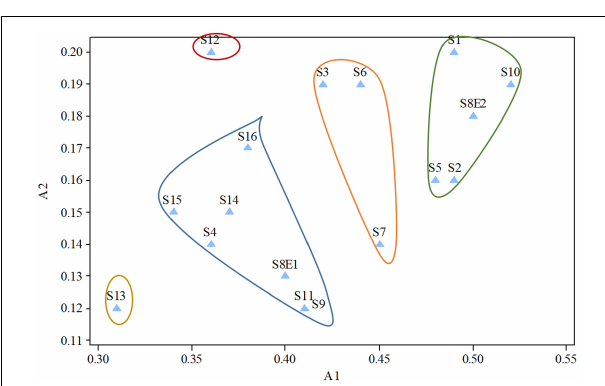
FIGURE 9 | Two-dimensional graphic of the Romero-Zarco asymmetry indices (A1: intrachromosomal asymmetry index, A2: interchromosomal asymmetry index) of 16 species (17 population) Pimpinella species. S1 ( P. affinis ), S2 ( P. eriocarpa ), S3 ( P. tragium ), S4 ( P. saxifrage ), S5 ( P. aurea ), S6 ( P. tragioides ), S7 ( P. olivieri ), S8 ( P. khayyamii ), S9 ( P. kotschyana ), S10 ( P. deverroides ), S11 ( P. olivierioides ), S12 ( P. anthriscoides ), S13 ( P. anisactis ), S14 ( P. peucedanifolia ), S15 ( P. khorasanica ), and S16 ( P. rhodantha